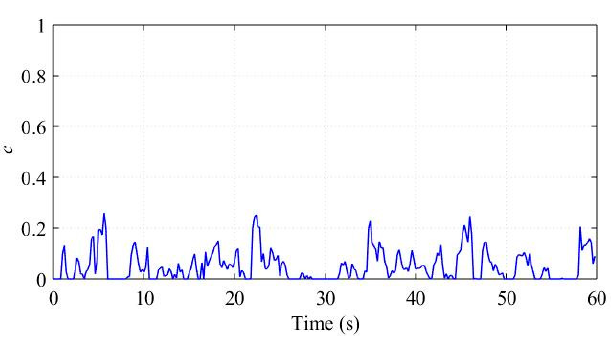
Figure 9. c in bumps and ditches experiment.